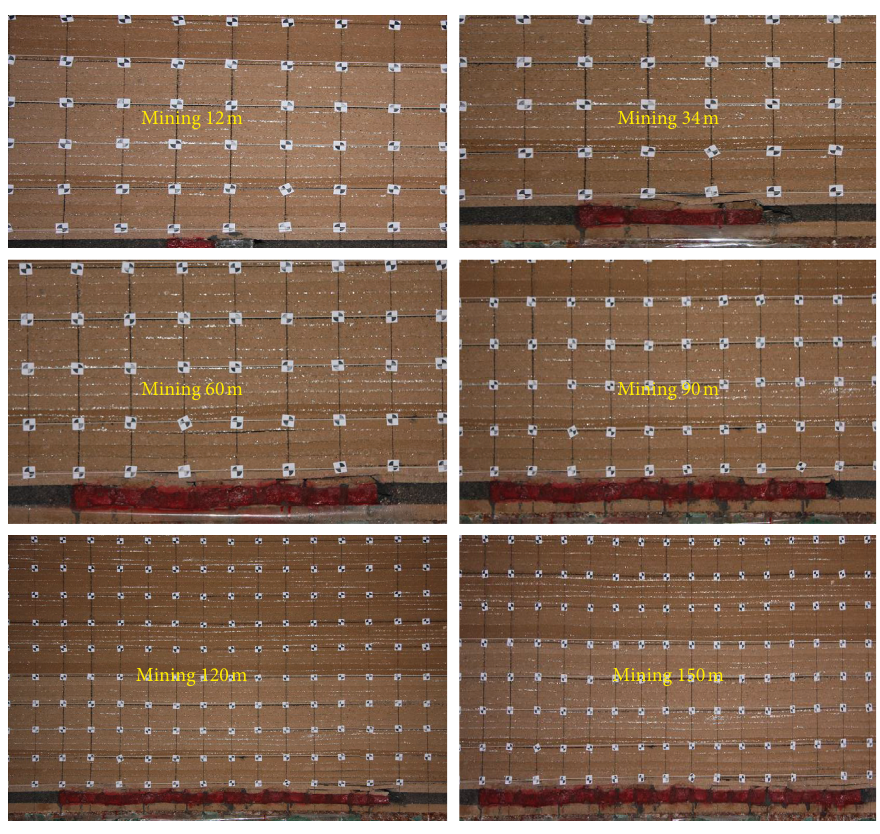
Figure 9: Movement and deformation of strata.